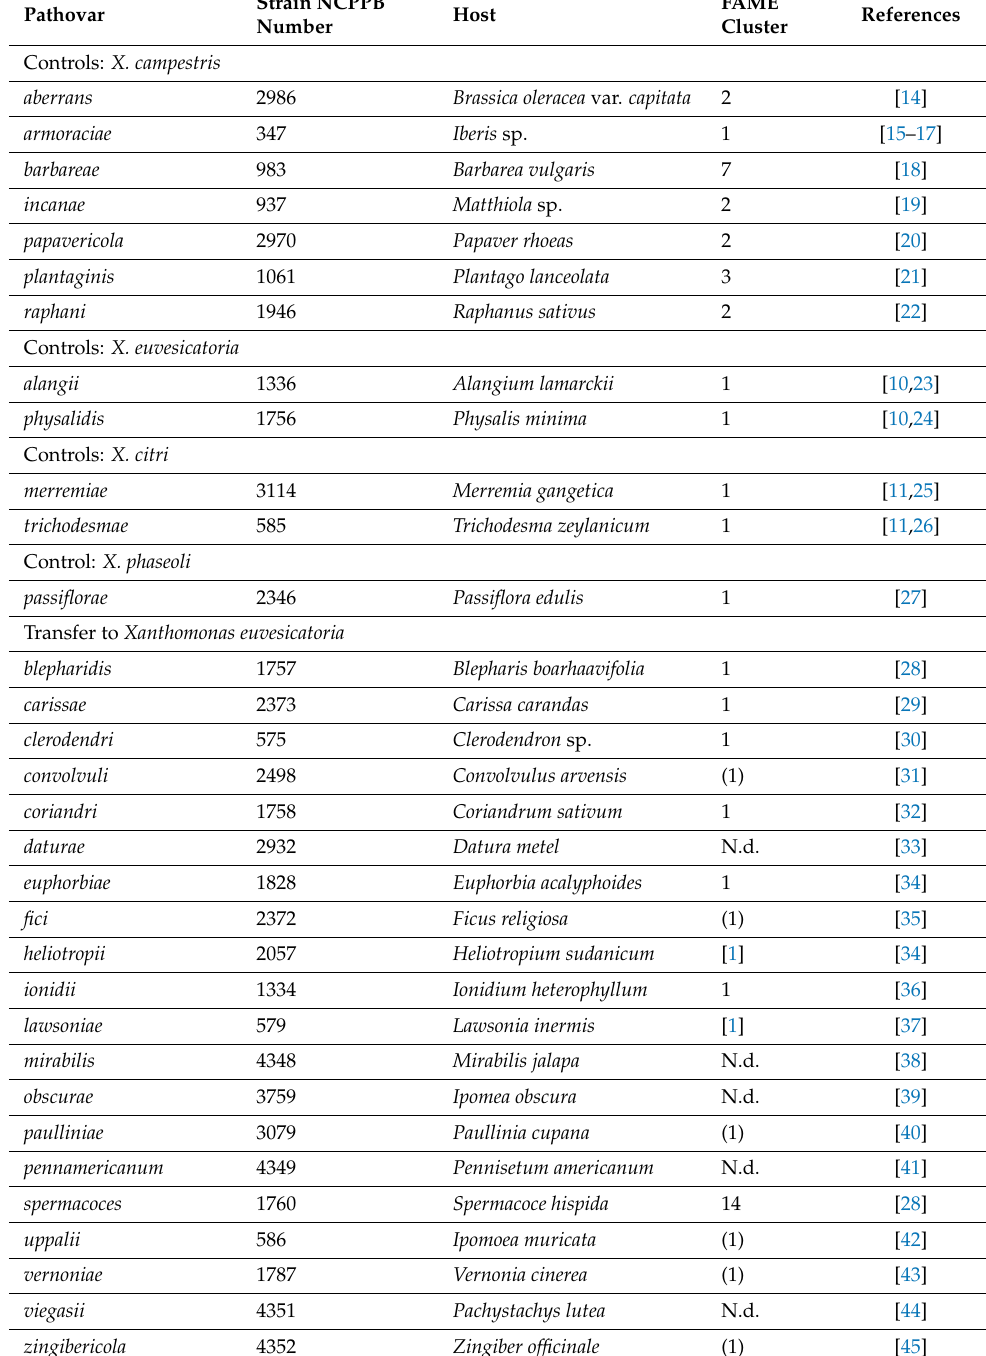
Table 1. Bacterial pathotype strains used in this study. Fatty acid methyl ester (FAME) clusters are shown according to their designation in the study by Yang and colleagues [9]. Those that belong to Yang’s FAME clusters 1 and 14 are indicated with those respective numbers. (1) Strains are related (>0.4 similarity index) to FAME cluster 1. Strains are remotely related (0.2–0.4 similarity index) to FAME cluster 1